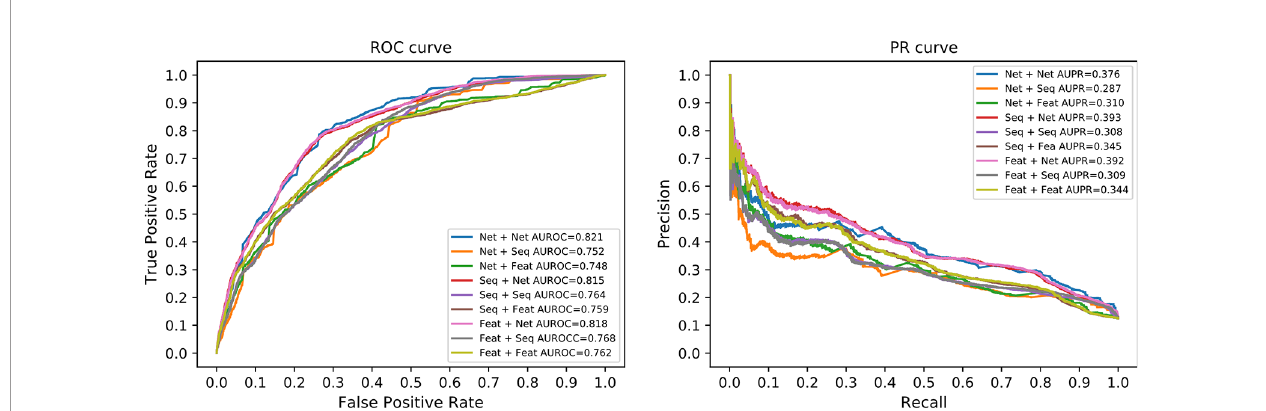
FIGURE 5 | ROC and PR curves of nine similarity combinations. The horizontal axis in ROC (left panel) is for FPR and the vertical axis for TPR. The horizontal axis in PR curve (right panel) is for recall and vertical axis for precision. Net is for network similarity. Seq is for sequence similarity. Feat is for statistical feature similarity. The fi rst part in the legend is for similarity measures of lncRNAs and the latter part for proteins. For example, the Net+Net means that we used network similarity for lncRNAs and proteins. The Net+Seq means that we used network similarity for lncRNAs and sequence similarity for proteins. Table 1 . According to these values, the prediction performance of our method is optimized when the network similarity measure was applied to both lncRNAs and proteins. Under this condition, the AUROC achieved 0.821, while the AUPR achieved 0.376. It seems liketheAUPRislow.However,byanalyzingthePRcurve,wefound that the precision is low when the recall is in the range of (0.1, 0.4). That is to say, some lncRNA – protein pairs with a high correlation score have no experimentally veri fi ed interaction between them.